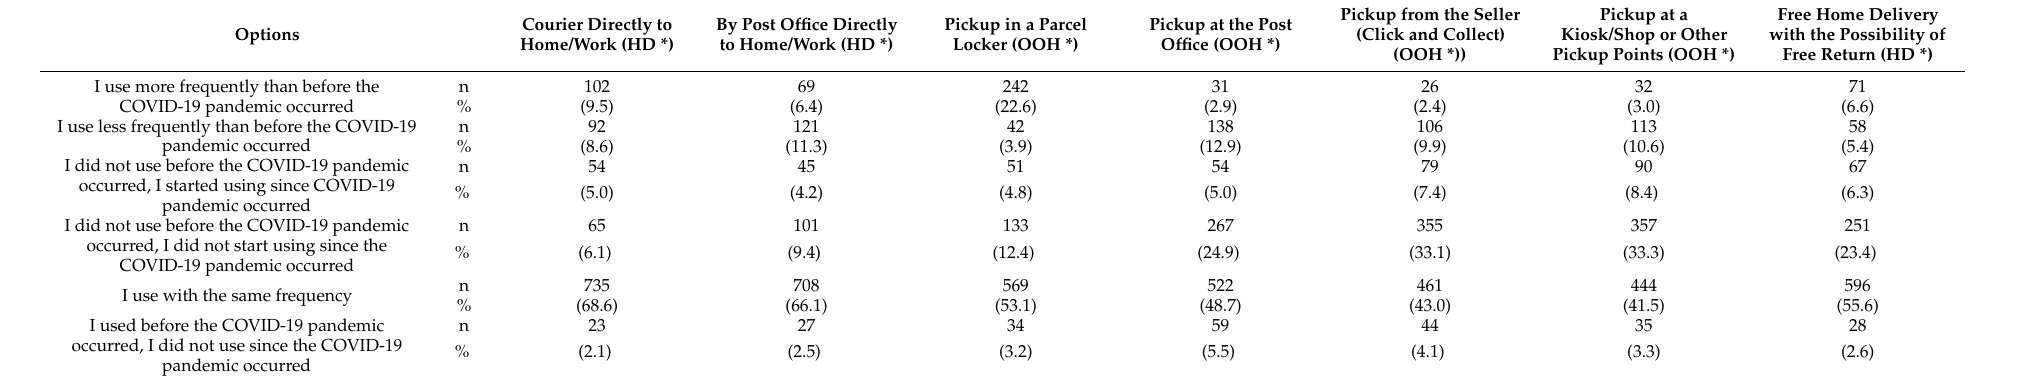
Table 3. Changes in the method of delivery of online purchases in rural areas during the COVID-19 pandemic (own